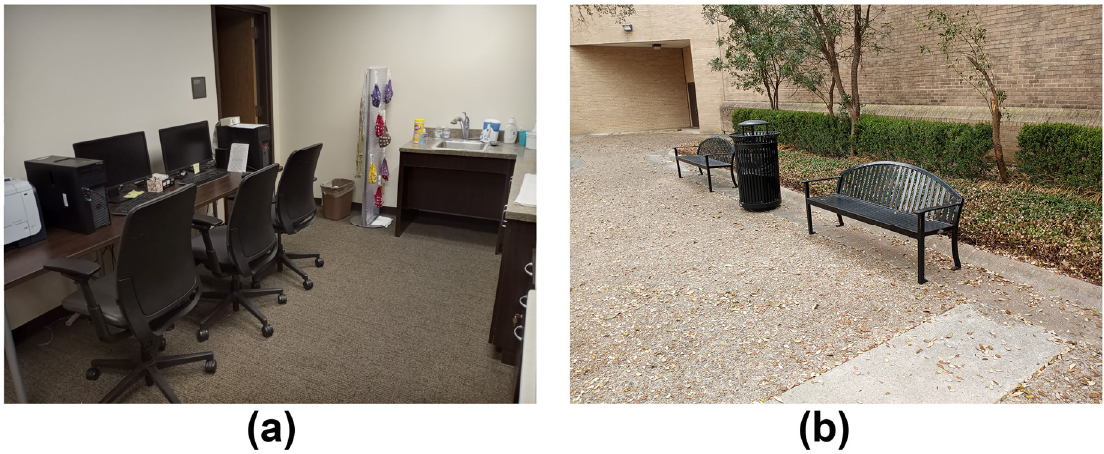
Figure 1. EEG recording environments: ( a ) Laboratory environment; ( b ) Outdoor